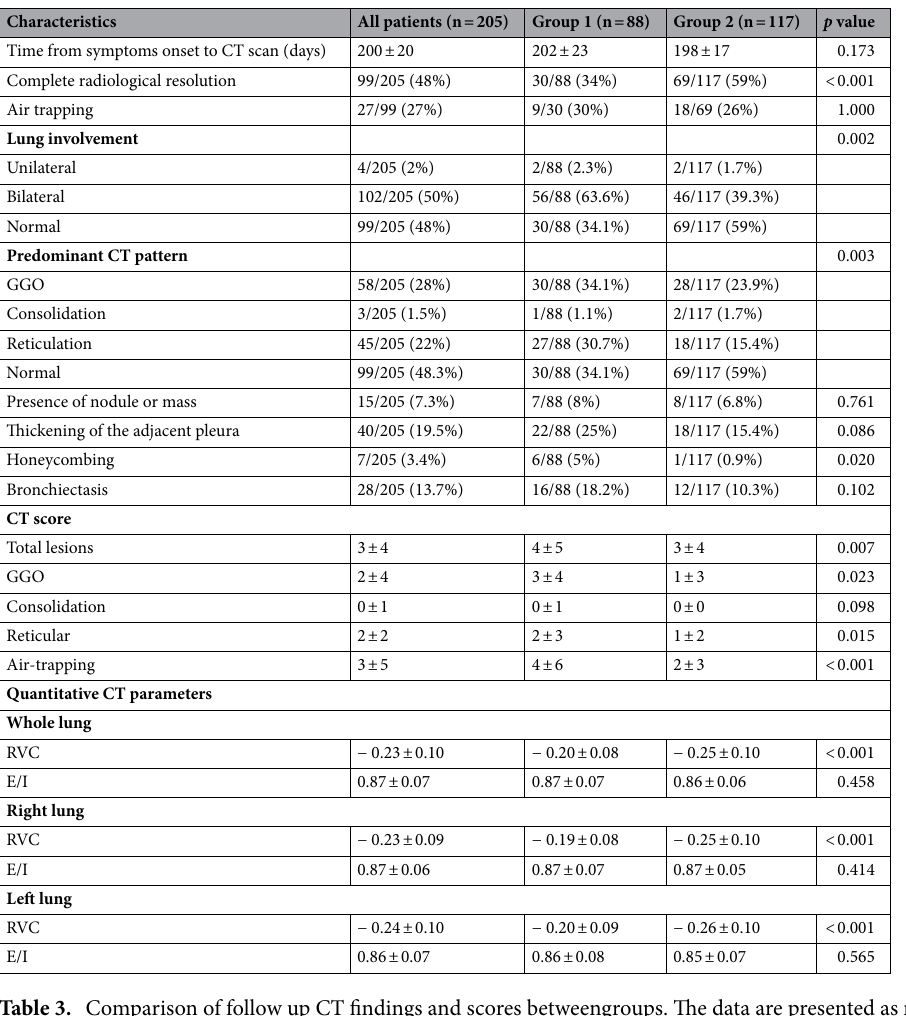
Table 3. Comparison of follow up CT findings and scores betweengroups. The data are presented as medians (interquartile ranges) or n/N (%). p values comparing patients with DL CO < 80%(group 1) and patients with DL CO ≥ 80% (group 2) are from χ 2 , Fisher’s exact test, independent-samples T test, or Wilcoxon rank-sum test.